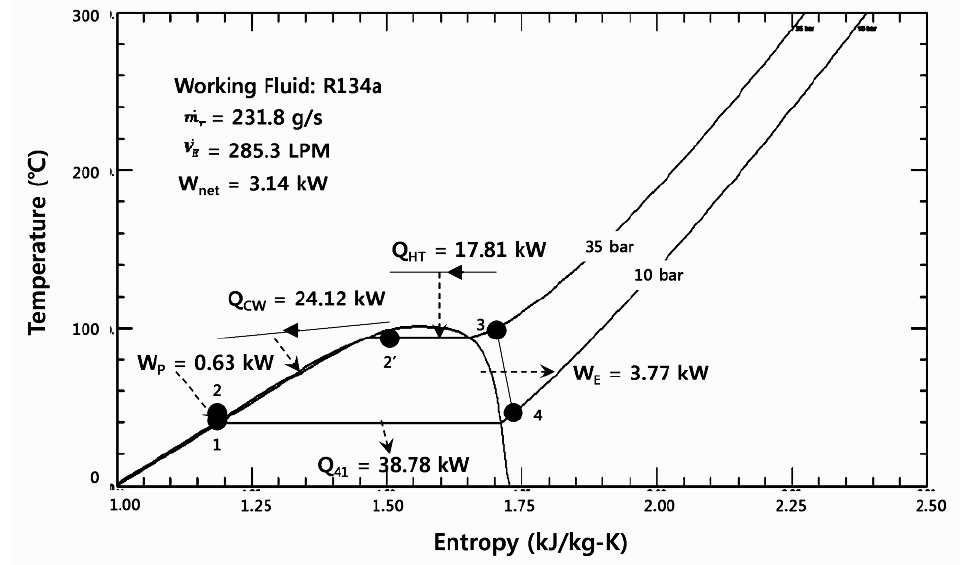
Figure 2. Temperature–entropy diagram of the low-temperature (LT) cycle.